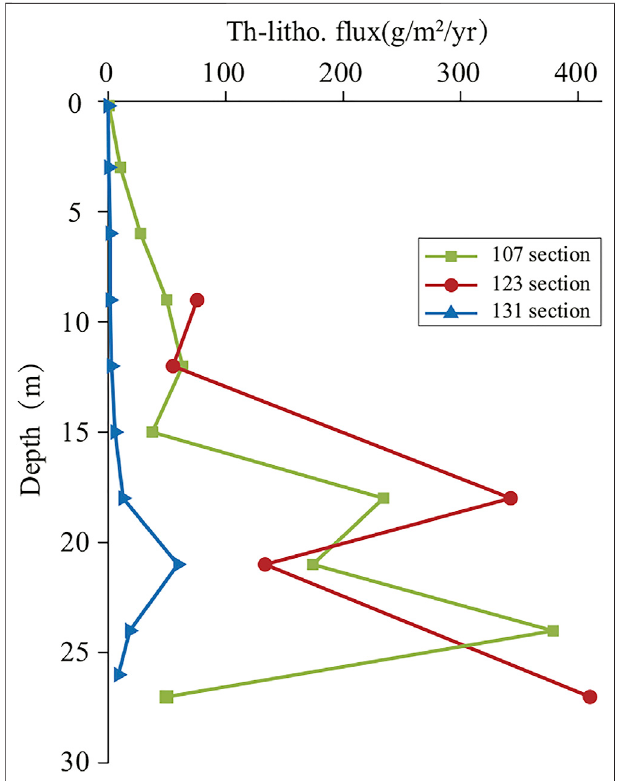
FIGURE 6 | Distribution characteristics of lithogenic fl ux in the depth pro fi les of Qinghai Lake.